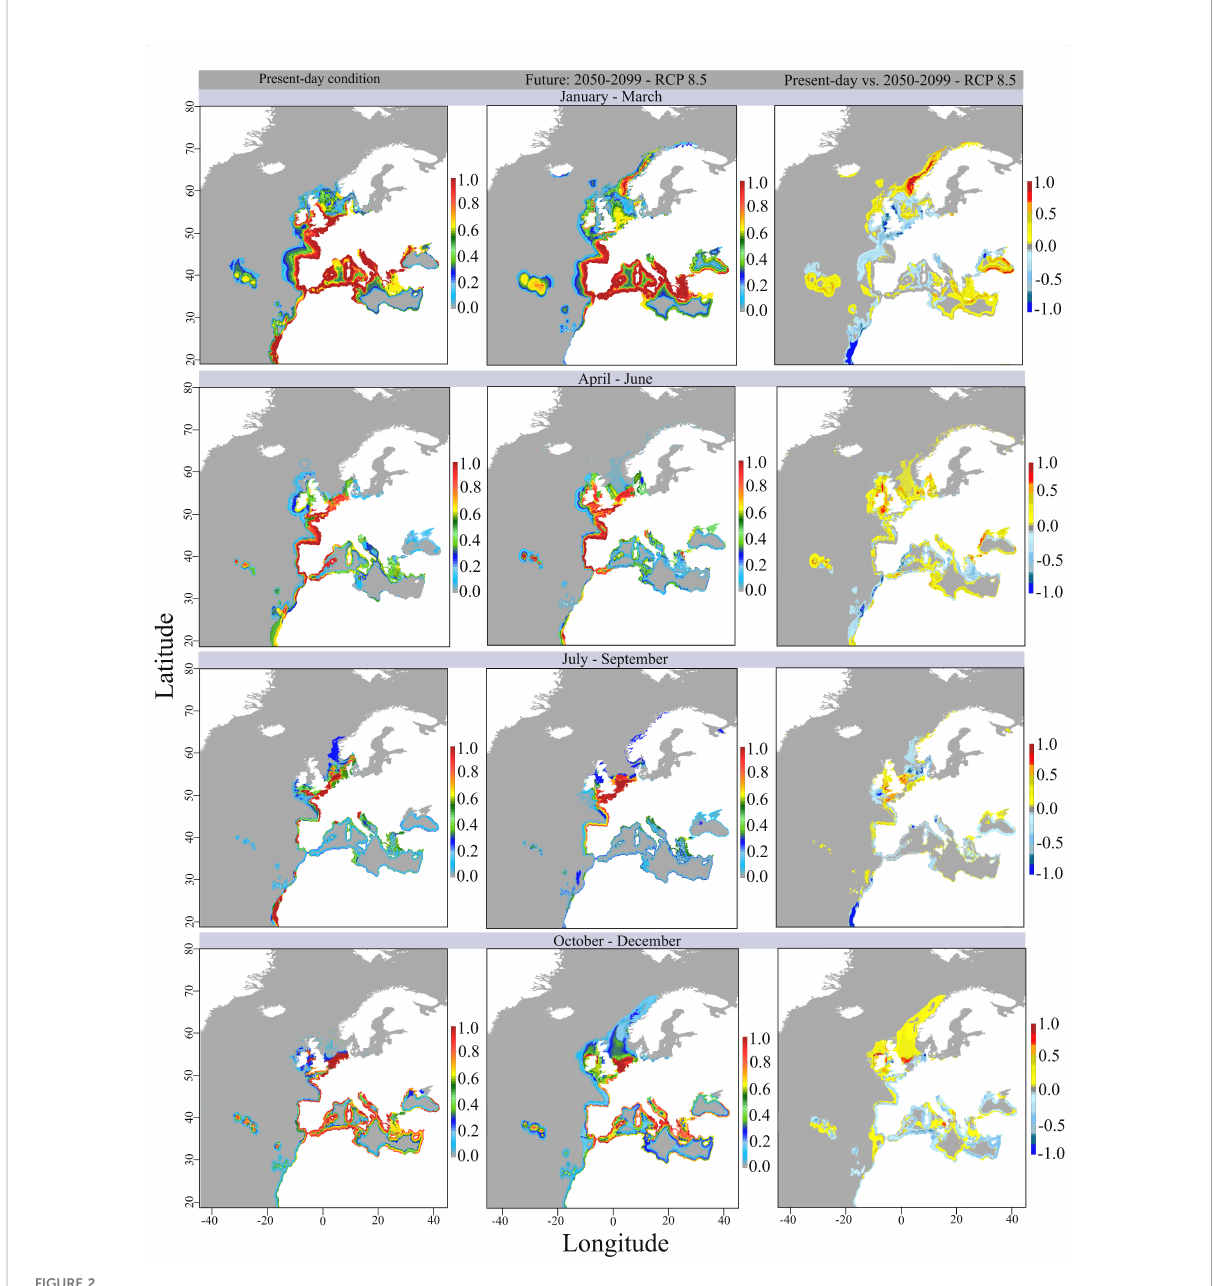
FIGURE 2 Maps of suitability indicating the variability in the probability of occurrence of eggs and larvae of Sardina pilchardus (from 0 to 1) as predicted by the seasonal ensemble models according to the present-day and future scenarios ( fi rst and second columns). Maps of shifts in suitability (third column) indicating gains and losses in the probability of occurrence of eggs and larvae as revealed by the differences between the present-day and 2050-2100 scenario under RCP 8.5. Geographic coordinate system: WGS